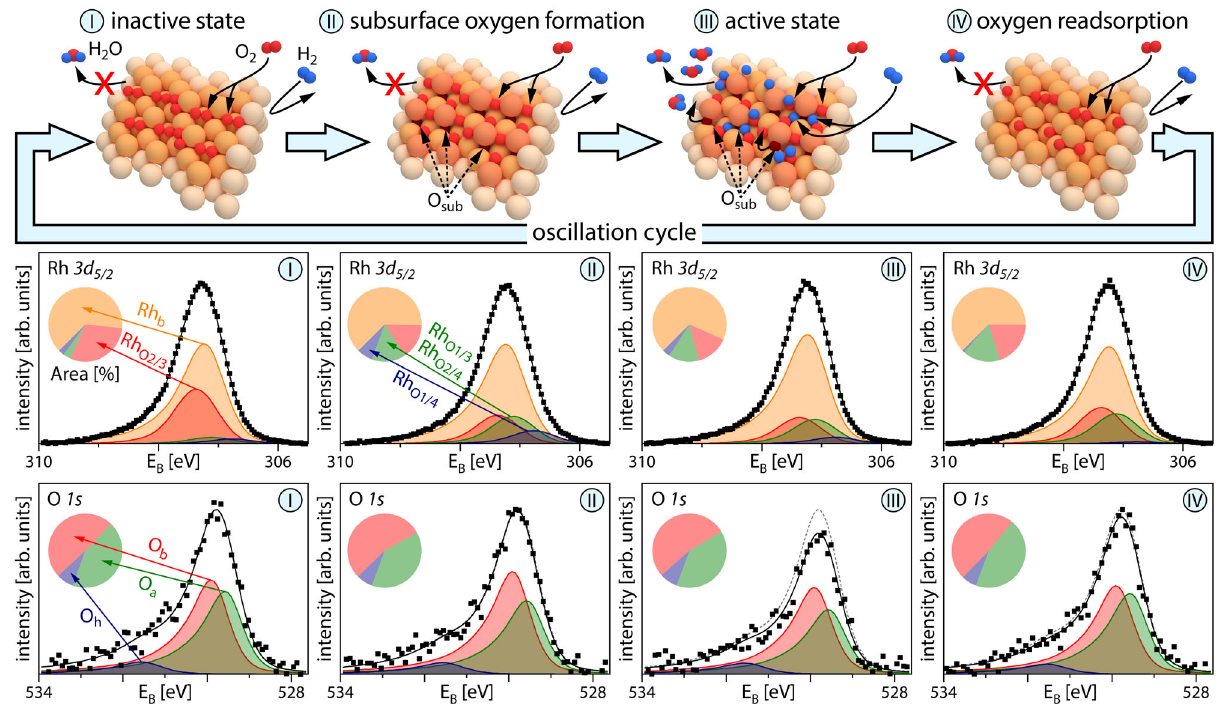
Fig. 4 Oscillating components in catalytic H 2 oxidation on Rh. Upper row: schematic ball models of the four stages of the oscillation cycle, O sub indicates subsurface oxygen species; middle row: deconvoluted Rh 3d 5/2 XPS spectra obtained during one cycle of oscillations on Rh(15 8 2). The Rh b component relates to bulk Rh, while the Rh O2/3 , Rh O1/3 /Rh O2/4 and Rh O1/4 components correspond to differently oxygen-bound Rh states; further details are given in the text. Squares: measured values; black solid line: sum of the deconvoluted components. The corresponding peak area contributions are given in the pie diagrams; bottom row: deconvoluted O 1s XPS spectra obtained during one cycle of oscillations. O a and O b components are associated with adsorbed atomic oxygen species, while O h corresponds to the OH reaction intermediate. Squares: measured values; black solid line: sum of the deconvoluted components. The dashed grey lines in steps II – IV indicate the measured data from step I as a reference. The corresponding peak area contributions are given in the pie